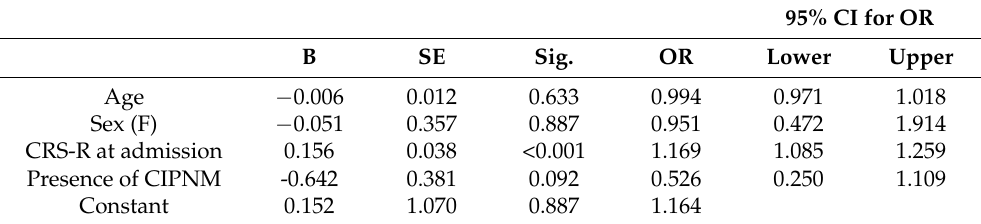
Table 2. Multivariate logistic regression analysis for the total study group.